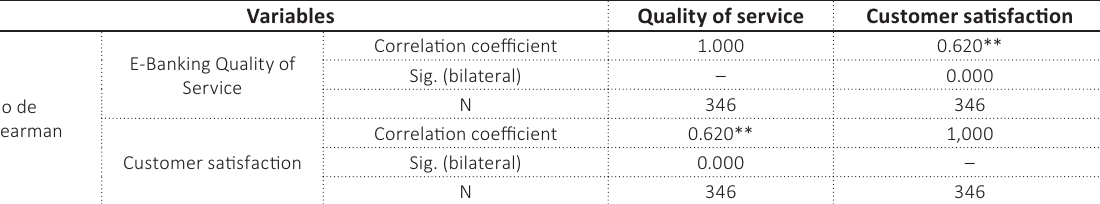
Table 5. Correlation coefficient and significance level between e-banking service quality variables and customer satisfaction